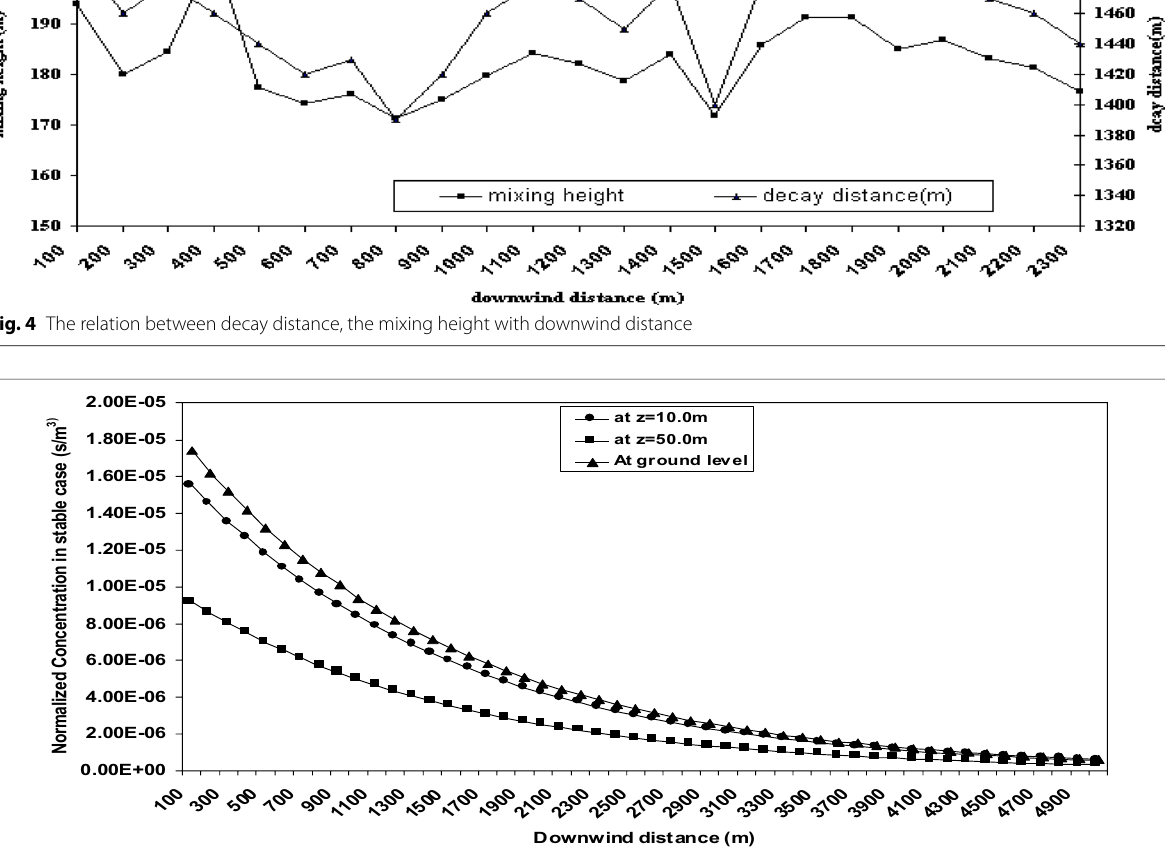
Fig. 5 Shows the variation between C (x, z)/Q via downwind distance at z